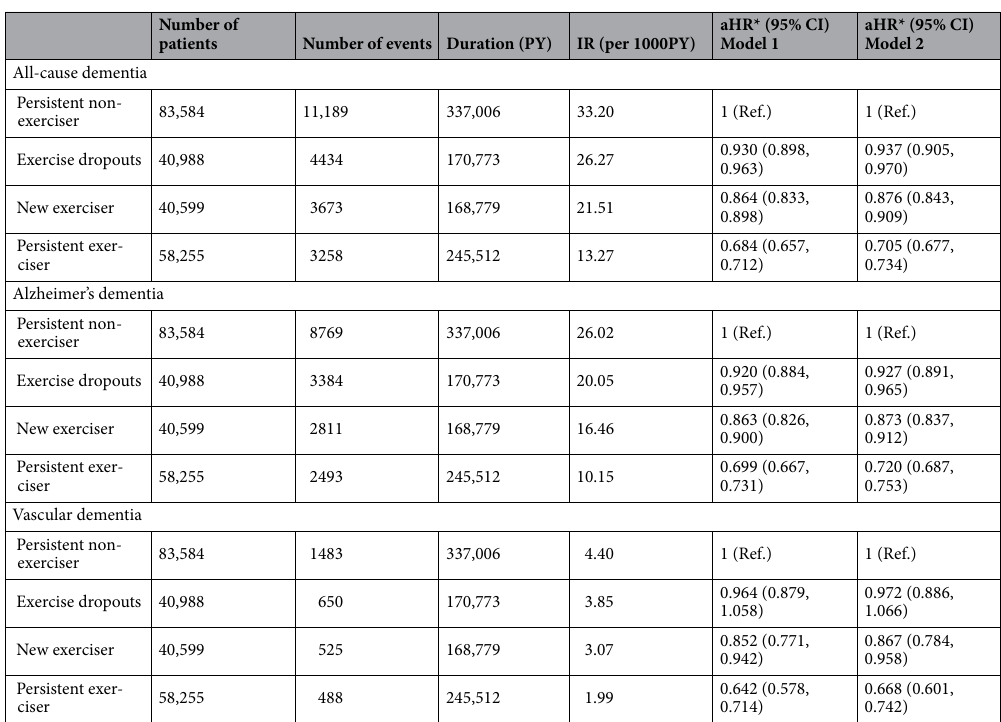
Table 2. Risk for all-cause dementia, Alzheimer’s disease and vascular dementia according to the exercise habit changes. IR, Incidence rate; aHR, adjusted hazard ratio; PY, person-years. # Model 1: age and sex-adjusted, Model 2: Model 1 + smoking status, alcohol status, low income, history of diabetes, hypertension, dyslipidemia and chronic kidney disease